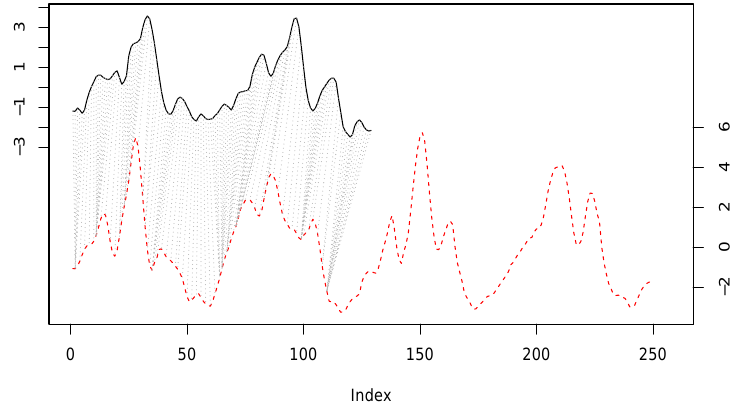
Figure 3. Subsequence DTW between a query representative pattern (the top black line) and another reference pattern x (the bottom red dotted